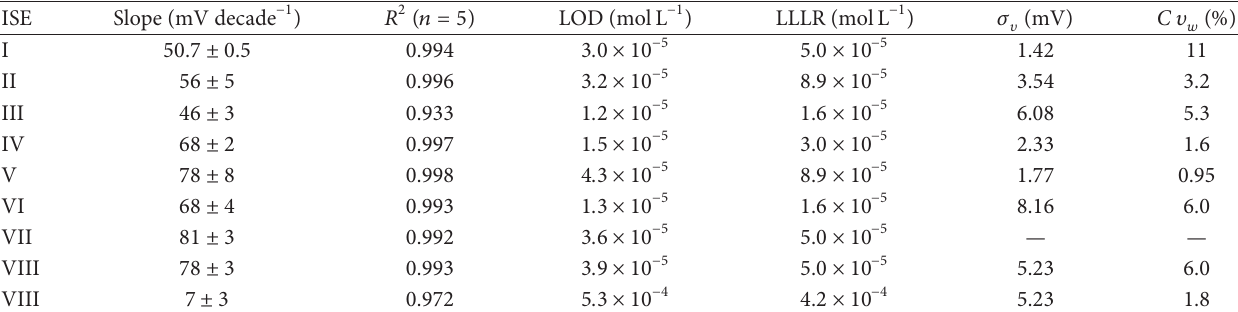
T 2: Main analytical features of the LMG potentiometric sensors